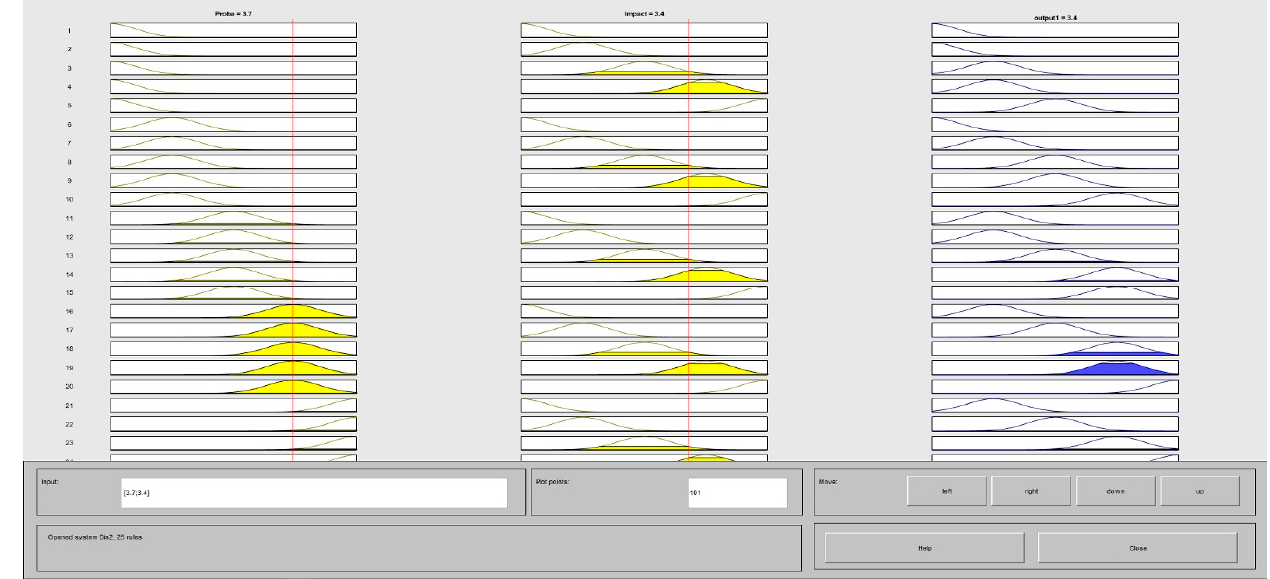
Figure 7. Output from Polyspace software package based on 25 rules.